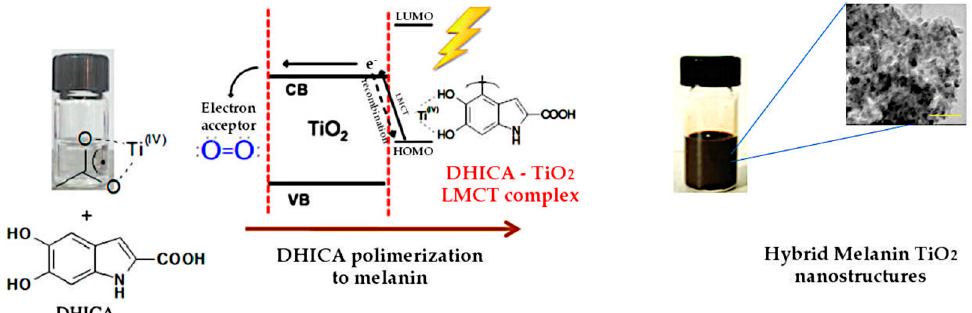
Figure 2. Photocatalytic activity of TiO 2 allows for 5,6-dihydroxyindole-2-carboxylic acid (DHICA) polymerization and formation of melanin–TiO 2 hybrid nanostructures with unique biocide activity. Reproduced with permission from [47], and from [45]. Copyright American Chemical Society, 2016 and The Royal Society of Chemistry, 2015, respectively.